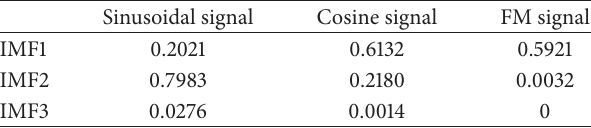
Table 2: The result of EMD